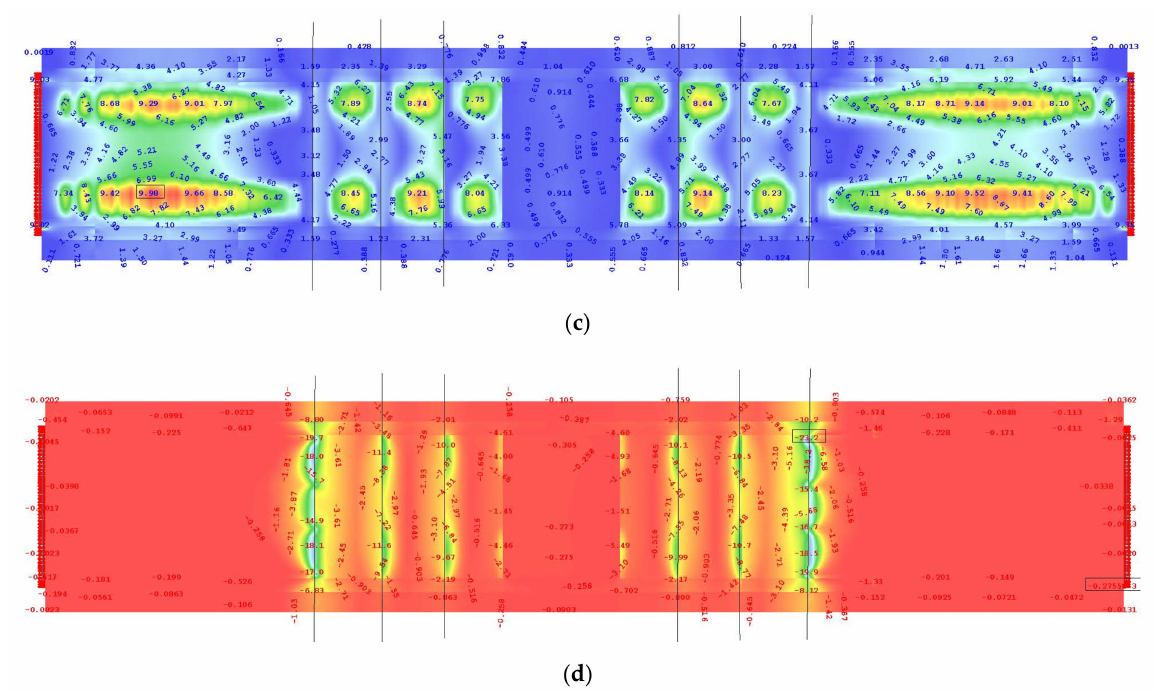
Figure A3. The envelope maps of characteristic values of bending moments M xx (kNm) in the deck plate: ( a ) Max Mxx (kNm) under the moving load q of class C; ( b ) min Mxx (kNm) under the moving load q of class C; ( c ) max Mxx (kNm) under the moving load K of class C; ( d ) min Mxx (kNm) under the moving load K of class C.